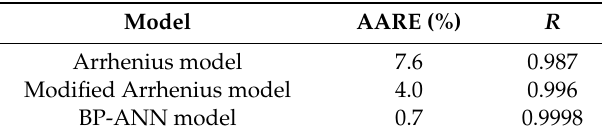
Table 5. The calculated values of ARRE and R for the Arrhenius model and BP-ANN model.